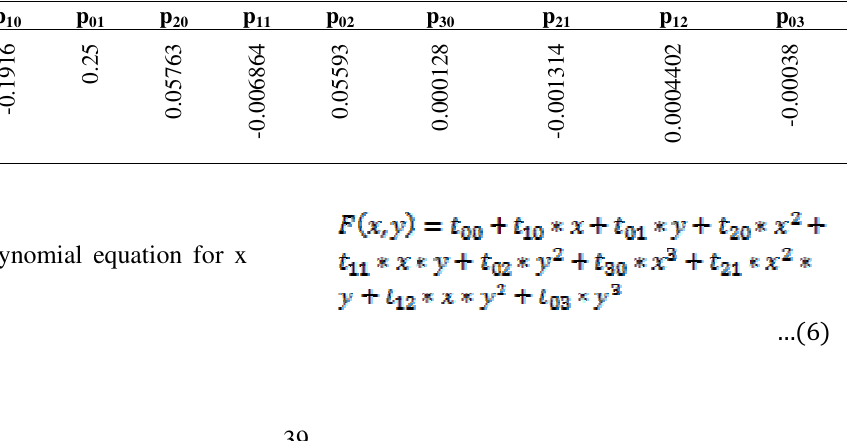
Coefficients of Polynomial of the First Case Study